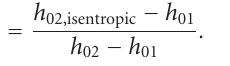
Figure 7: Computational domain used in the simulations (only one blade passage is used in the simulation) and approximate position of the actuator (the actuator is on the suction side only).